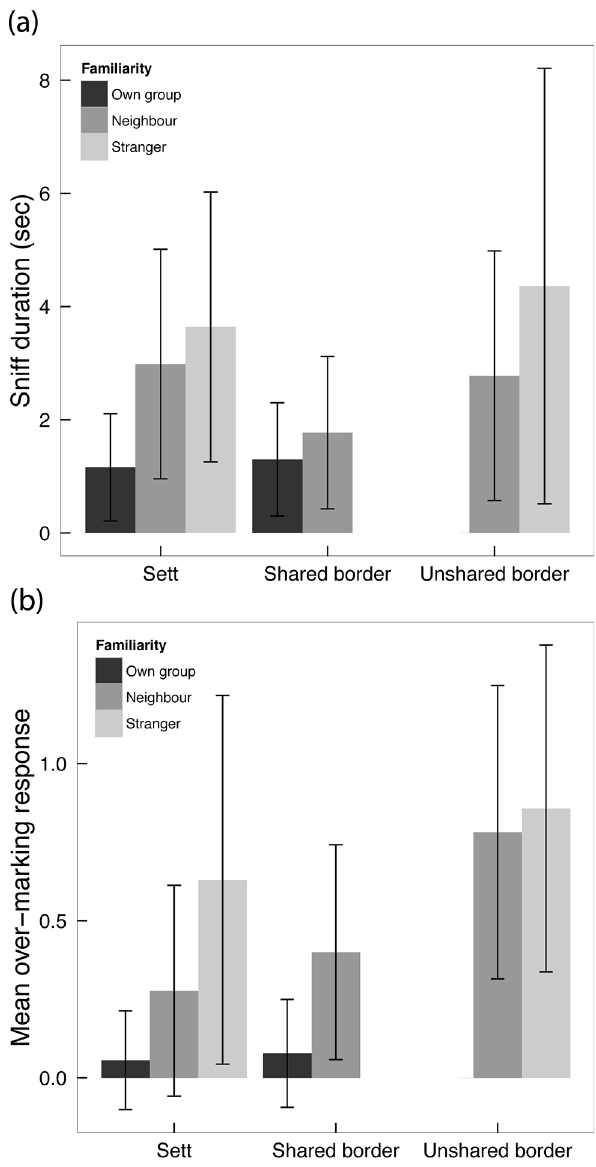
Fig 1. Group-level variation in responses to AGS from donors of different levels of familiarity. Mean ( ± SD) group level (a) duration of sniffing responses in seconds; and (b) number of subcaudal-marking responses per potential response to AGS from own – group ( n = 20 trials), neighbours ( n = 35) and strangers ( n = 30) presented at either the responding group ’ s sett, or a border (shared or unshared) between the responding group and the scent